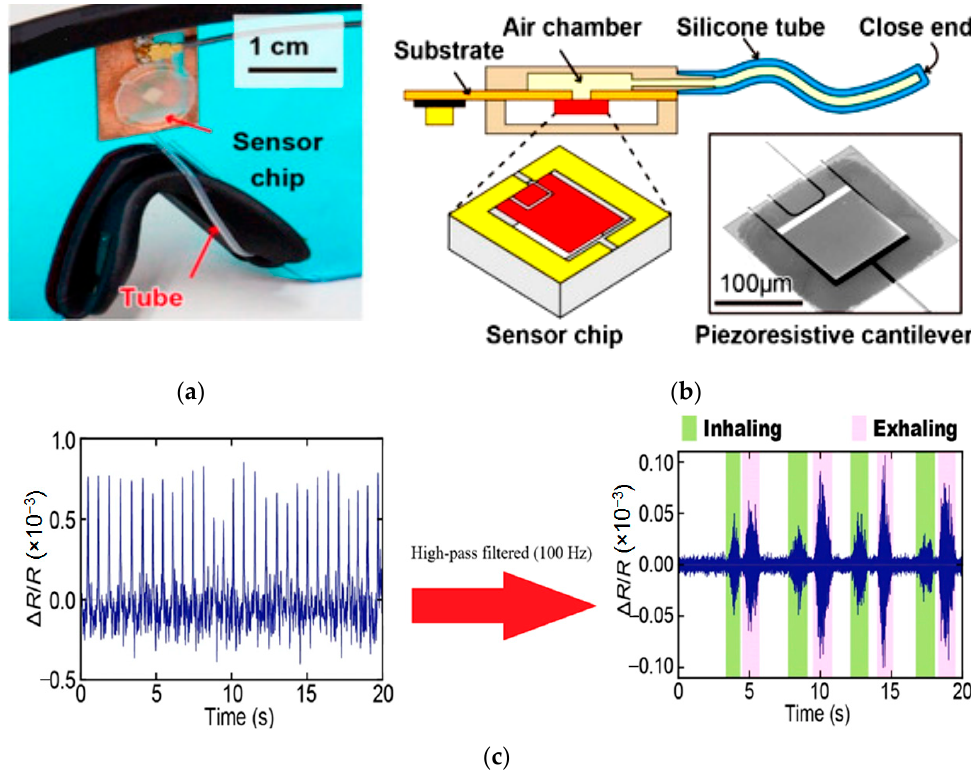
Figure 2. Prototype of the device discussed in [52] ( a ) and schematic representation of the piezore- sistive sensor ( b ). Output signal includes both pulse wave and respiration component (left) and after being filtered by a 100 Hz high-pass for extracting the breathing component (right) ( c ).